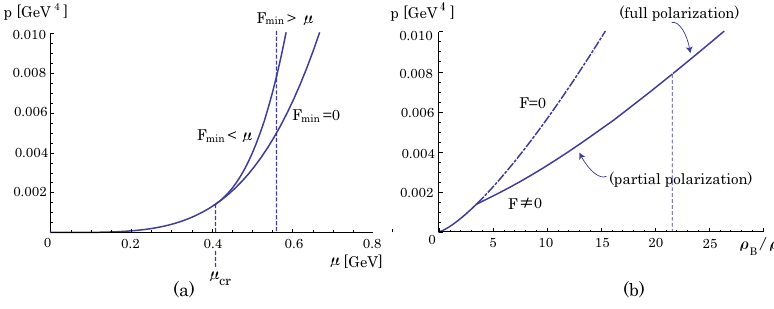
Figure 2. The pressures as a function of (a) the quark chemical potential and (b) the baryon number density divided by the normal nuclear density ρ 0 = 0 . 17 fm − 3 are